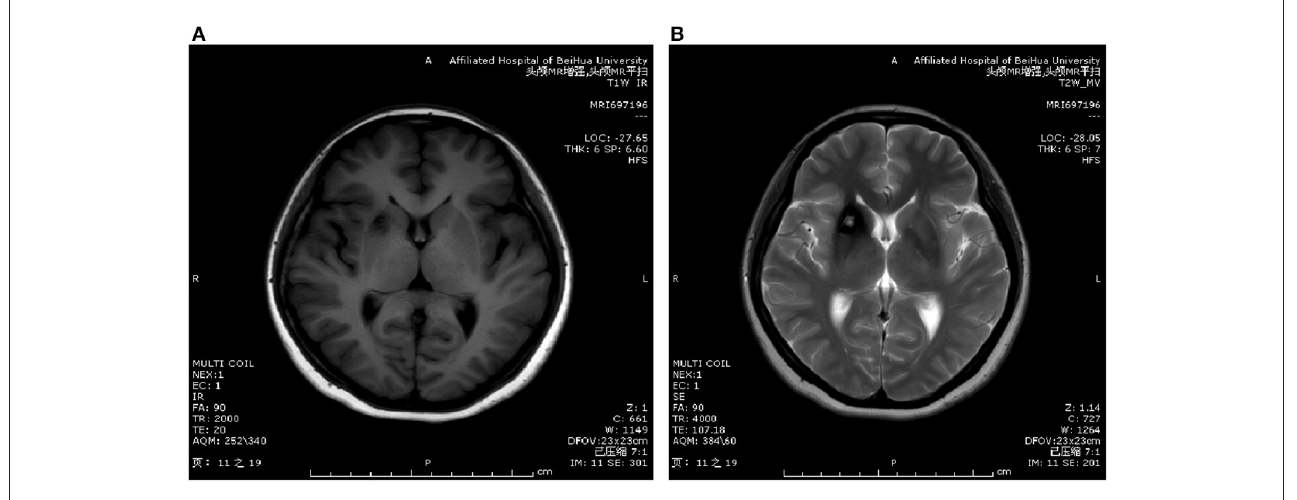
FIGURE2 MRI scanning image. (A) Shows T1WI image and (B) shows T2WI